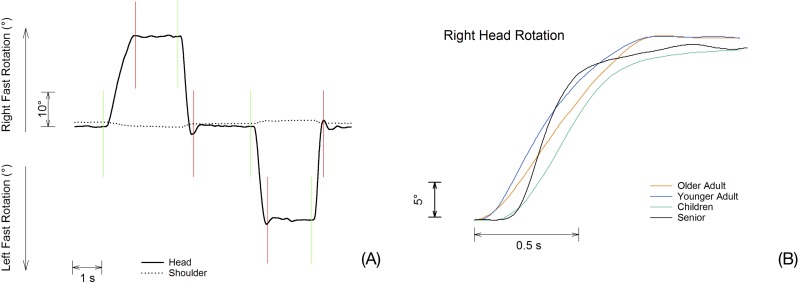
Typical trace during one complete cycle and example of different performances achieved by individuals of different age-group.(A) Typical trace of head-neck complex and trunk rotation during one complete cycle (center-right-center-left-center). Analysis was conducted during head rotation (ascendant/descendant solid line) phase with placement of cursors from the beginning (green) to the end of the rotation (red). (B) Example of right axial rotation performed by individuals of different age-group.